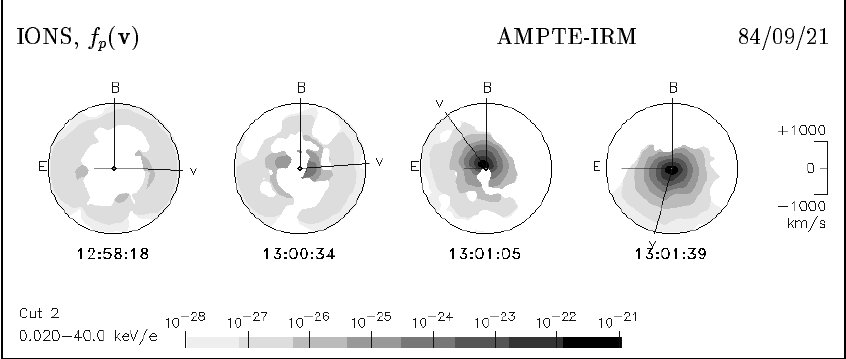
Fig. 3. Ion distributions in the energy range of 20eV–40keV measured on 21 September 1984. The format is the same as in Fig. 2.